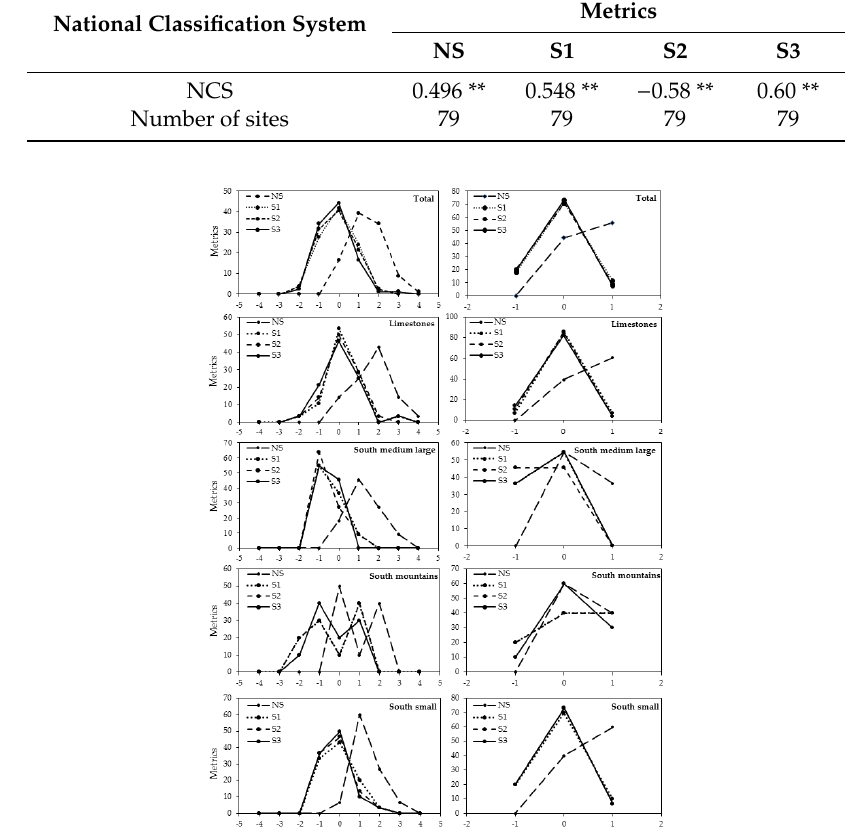
Table 7. Spearman correlations between the National Classification System (NCS) classification and metric classifications (** p < 0.01).